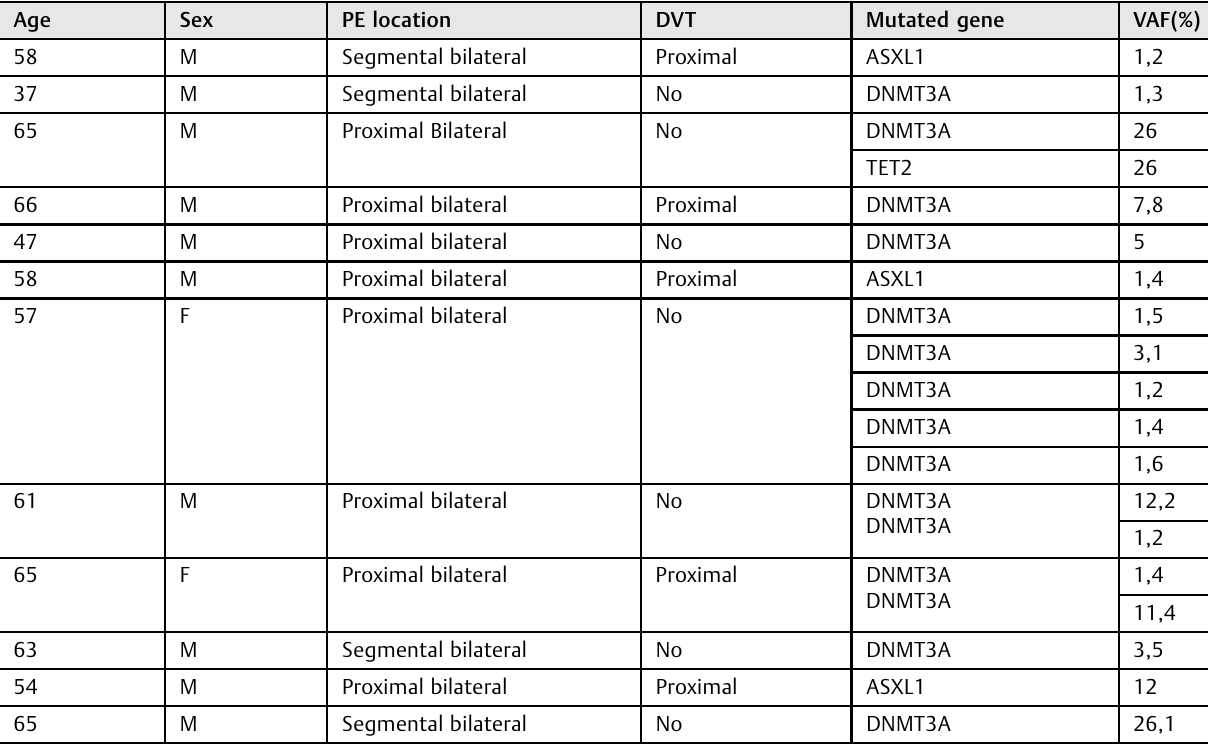
Abbreviations: CHIP, Clonal hematopoiesis of inderdermined signi fi cance; DVT, Deep Vein Thrombosis; PE, Pulmonary Embolism; VAF, Variation allelic